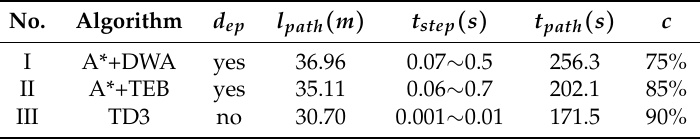
Table 2. Planning indexes in small-scale environment.